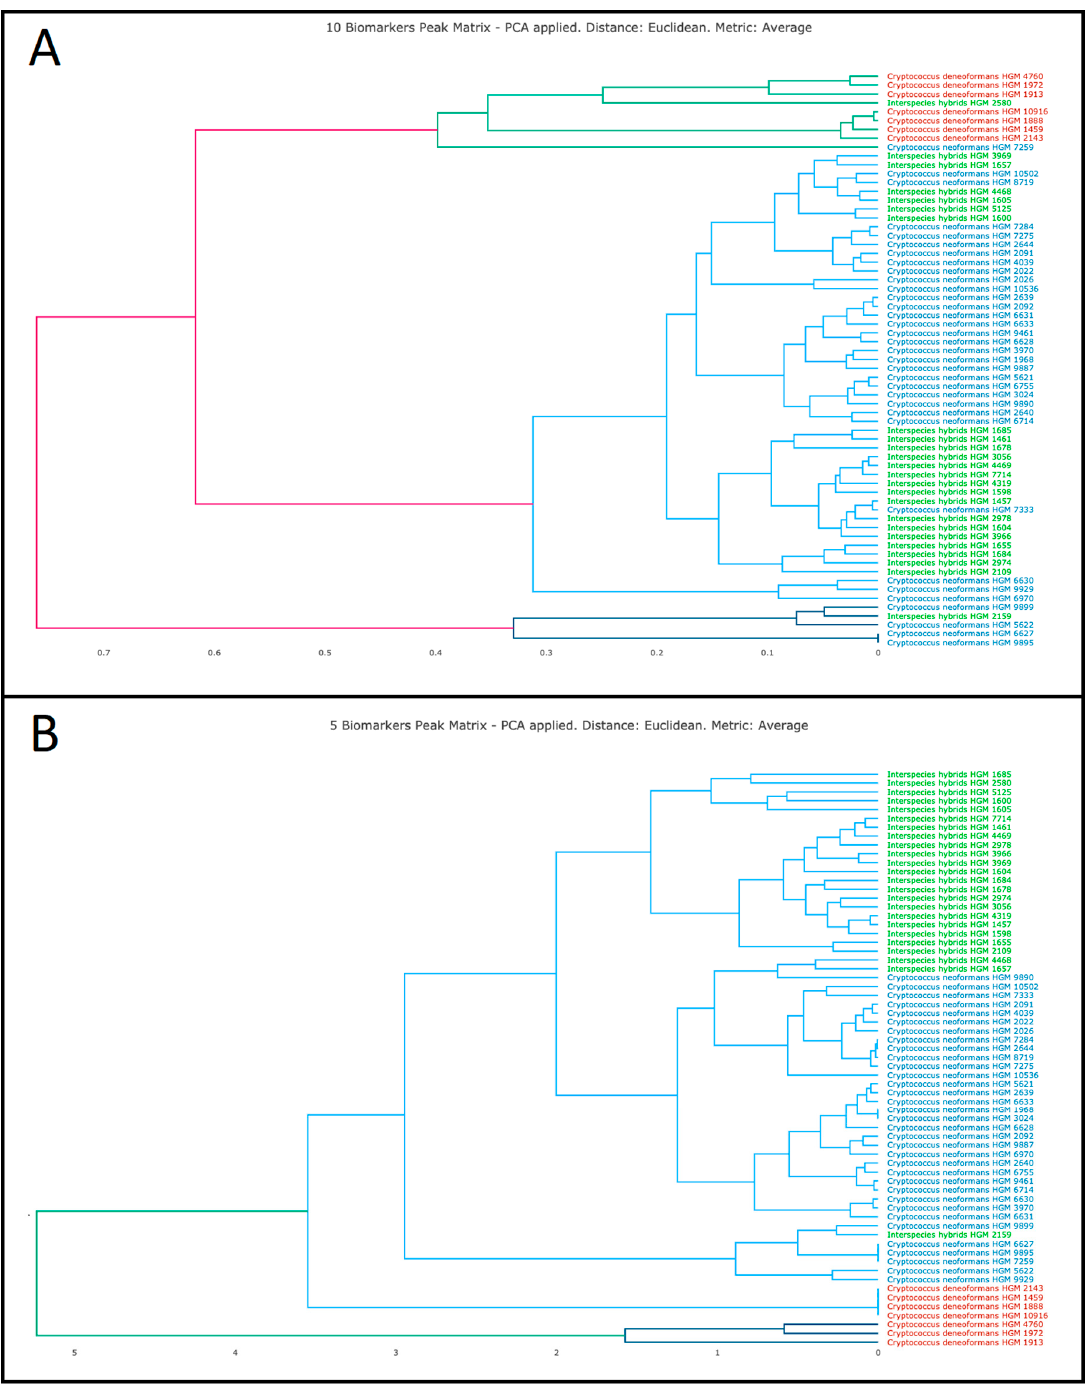
Figure 2. Clustering of 65 Cryptococcus isolates included in this study in a two-step approach. Five isolates could not be recovered from culture for further analysis: ( A ) clustering using 10 biomarker peaks and PCA; and ( B ) clustering using 5 biomarker peaks and PCA.